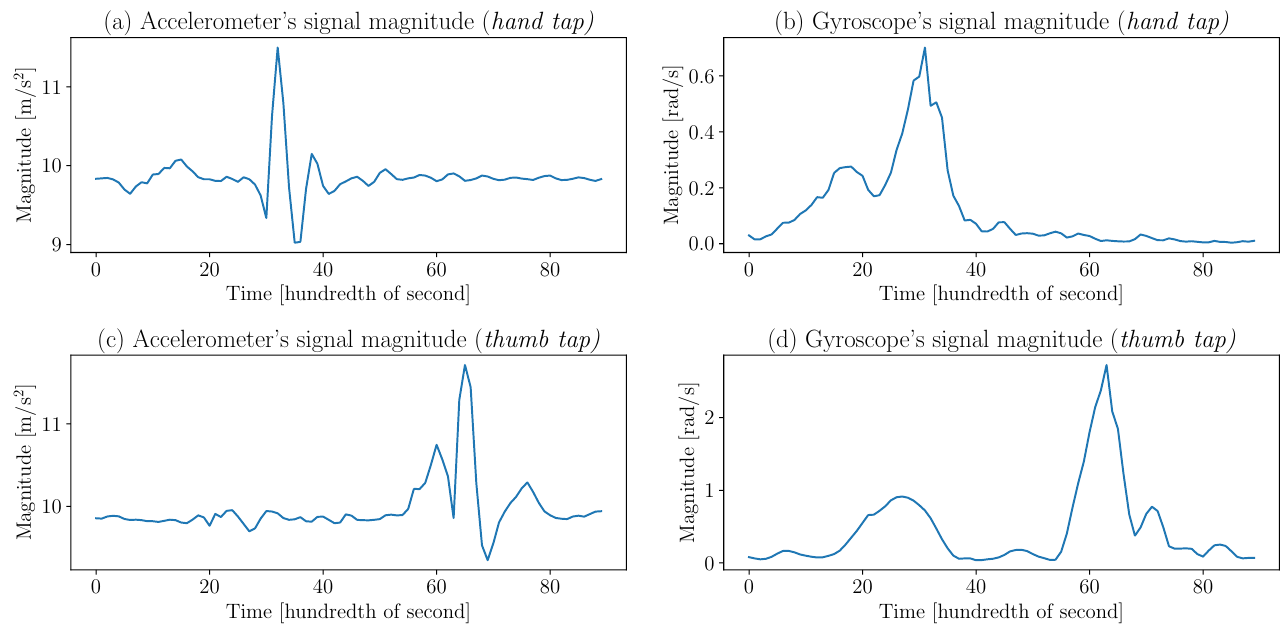
Figure 3. Input signal examples for ( a ) a hand tap acceleration, ( b ) a hand tap angular velocity, ( c ) a thumb tap acceleration, and ( d ) a thumb tap angular